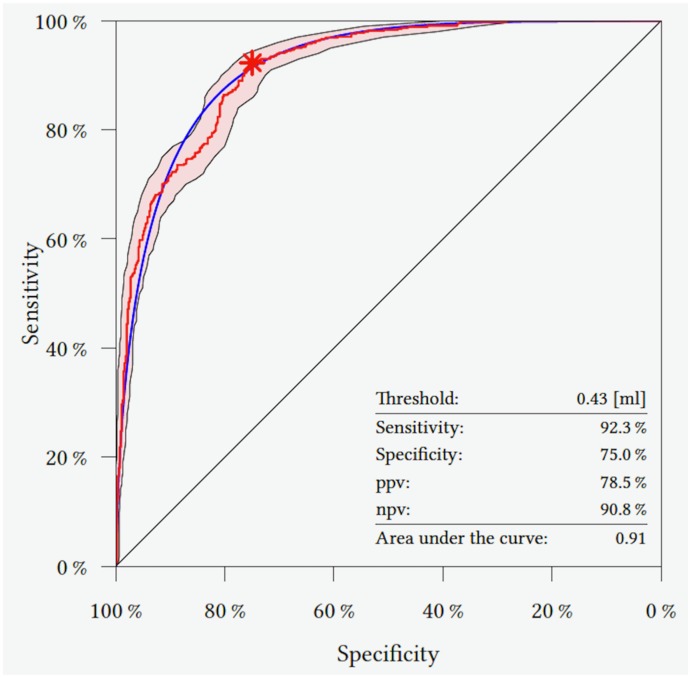
ROC curve determining the best threshold (maximum sensitivity and maximum specifity) for development of vasogenic edema of all BM in the study (red star = 0.48 ml).The red line represents the empirical ROC curve, the light red area shows the 95% confidence interval, and the blue line is a smoother of the empiric ROC curve. Sensitivity, specifity, positive predictive value (ppv), negative predictive value (npv), and area under the curve are also given.